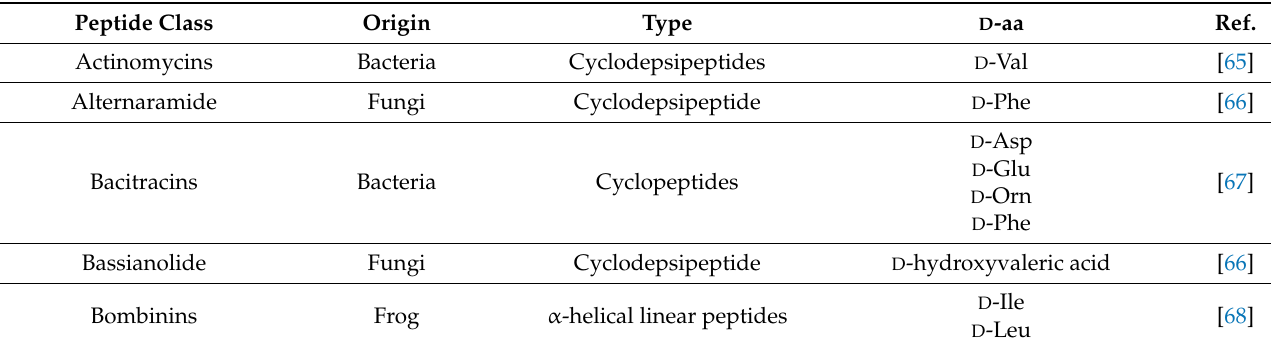
Table 1. Natural AMPs with D